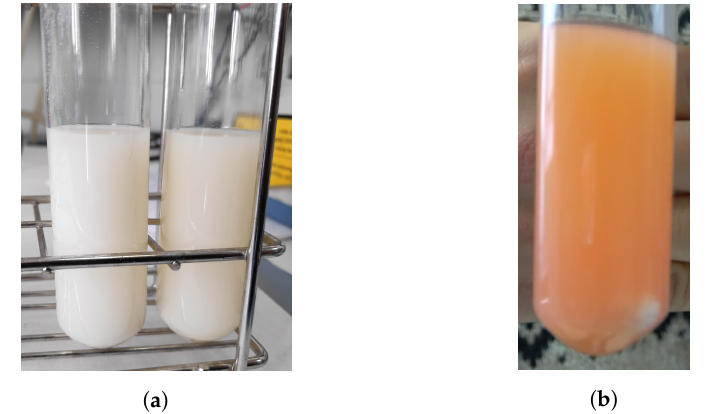
Figure 8. Appearance of the solution in the test tubes: ( a ) after photocatalytic dye degradation in designed reactor (left) and the handmade device (right). ( b ) Before application of UV